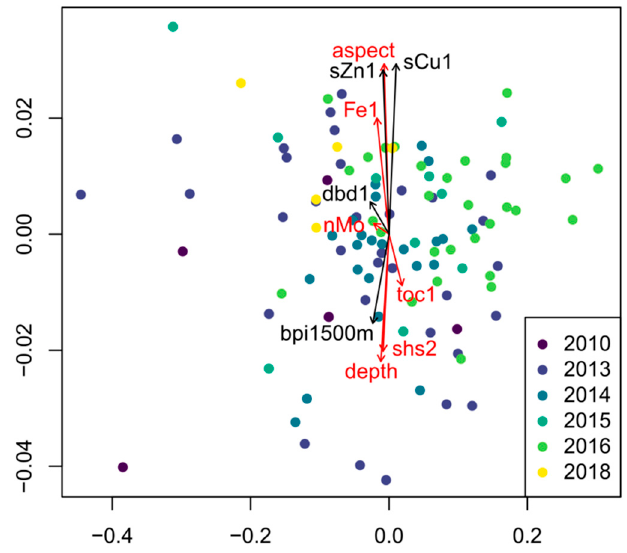
Figure 2. Non-metric multidimensional scaling of the Bray-Curtis Dissimilarity (stress: 0.02) com- puted for the meiofauna community on high taxonomic level regarding each core as one individual sample. The colours of the points indicate the year of sampling. Vectors correlate environmental variables to the community patterns; red arrows indicate high significance of the vector; black arrows indicate low significance. aspect: cardinal direction of the slope, BPI1500m: bathymetric position index across a radius of 1.5 km, dbd4: dry bulk density in 4 cm sediment depth, depth: water depth, nMo: content of molybdenum in polymetallic nodules, sCu1: content of copper in 1 cm sediment depth, sFe1: content of iron in 1 cm sediment depth, sZn1: content of zinc in 1 cm sediment depth, shs2: shear strength in 2 cm sediment depth, toc1: total organic carbon in 1 cm sediment depth. Table 3. Model evaluations of the random forest regressions computed for overall meiofauna abundance, taxon richness and diversity as well as different higher meiofauna taxa according to the percentage of explained variance and Pearson’s correlation using backscatter and bathymetry only (a), sediment and nodule parameters only (b) or all available predictors (c) as predictor variables. (* indicates significance <